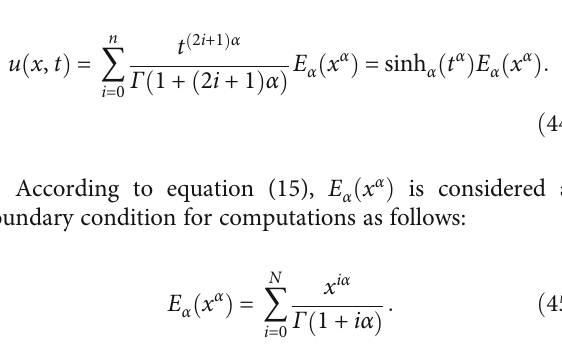
Figure 1. For Figures 1 and 2, α = 1 and α = ln 2/ln 3 ,